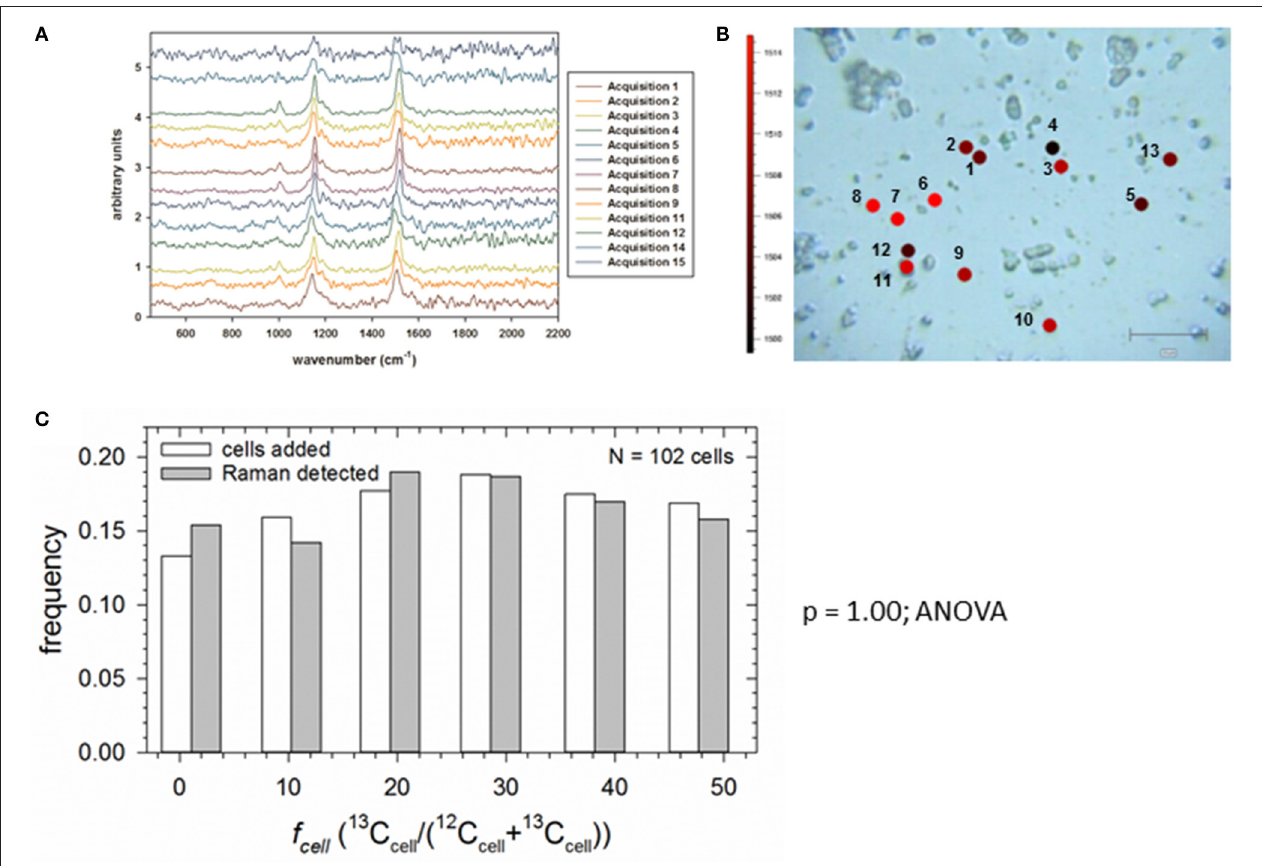
FIGURE 7 | SCRR of an artificial assemblage constructed of known concentrations of Synechococcus sp. populations with distinct f cell labeling. (A) Stacked SCRR spectra from cells 1–13. (B) Bright field image of cells 1–13 targeted for Raman interrogation in a single field superimposed with (C) Comparison of frequency of occurrence of cells added from each f cell population (open bars) and those detected by SCRR (shaded